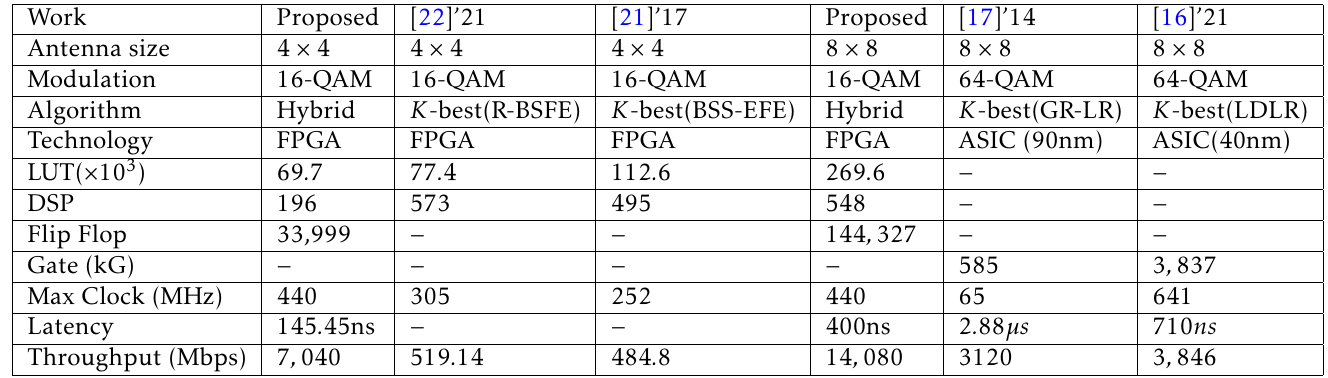
Table 2. Comparison of the proposed MIMO detector and the